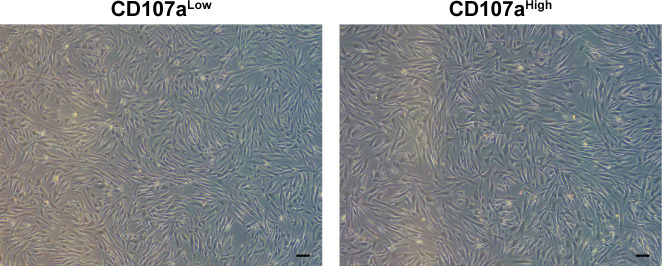
Representative morphology of confluent human CD107alow and CD107ahigh cells.Passage 4. N = 8 samples examined. Black scale bar: 100 μm.